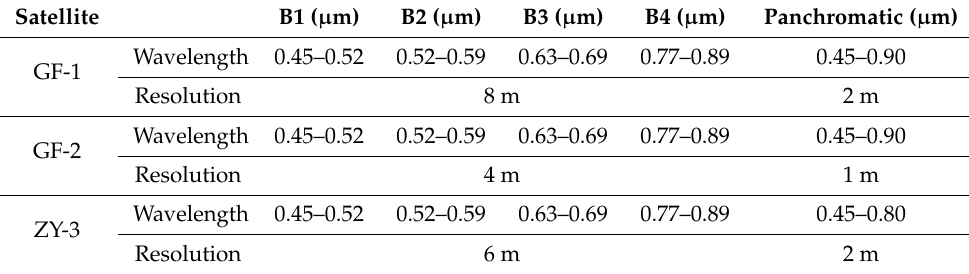
Table 1. Basic parameters of the satellite imagery.